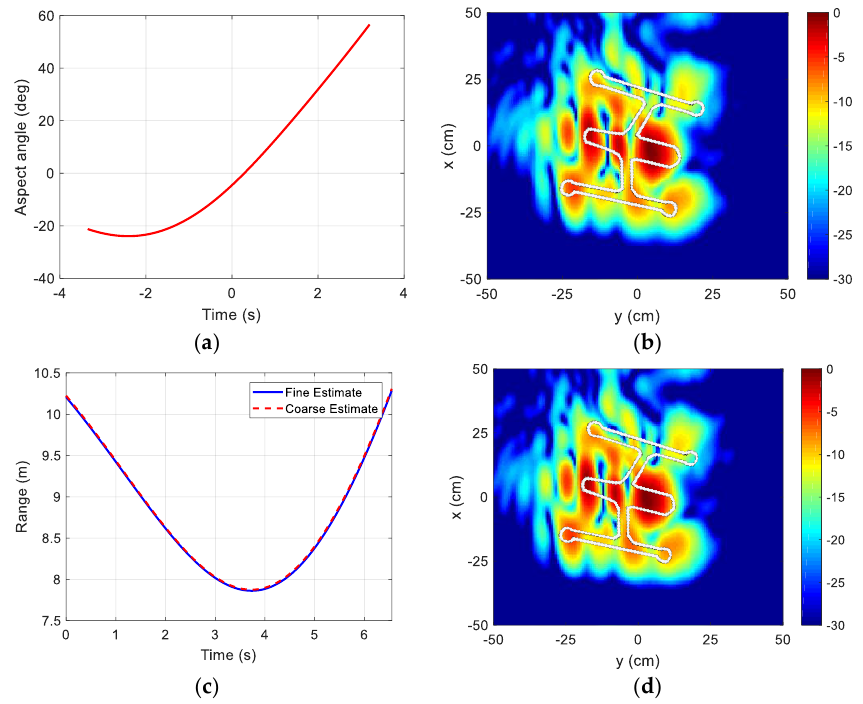
Figure 11. Drone ISAR image formation. ( a ) Drone aspect angle vs. time; ( b ) Coarse motion compensation image; ( c ) Coarse vs. fine estimate; ( d ) Fine motion compensation image.